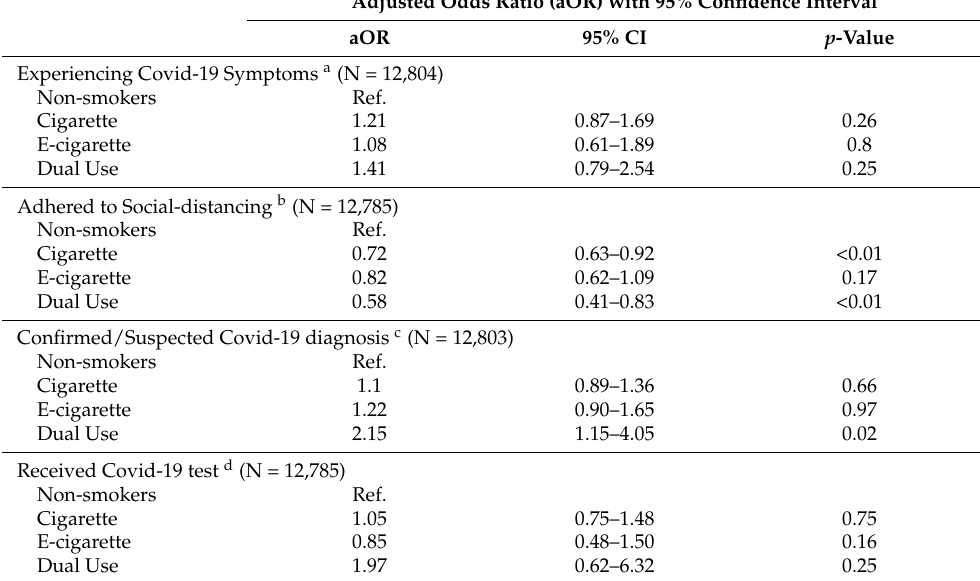
Table 2. Associations between COVID-19–related measures and exclusive or dual use of cigarette and